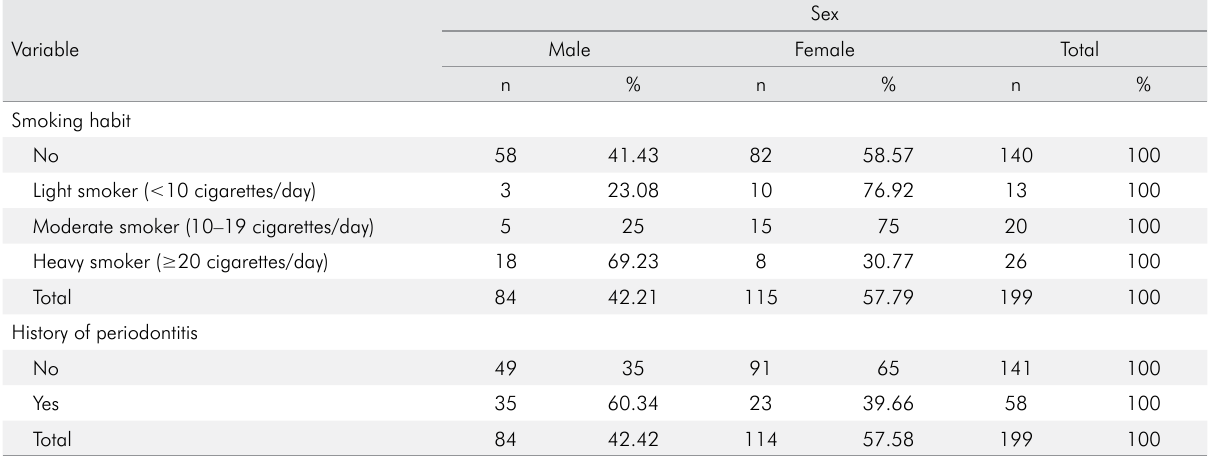
Table 2. Smoking status and periodontitis history distribution of patients according to sex.